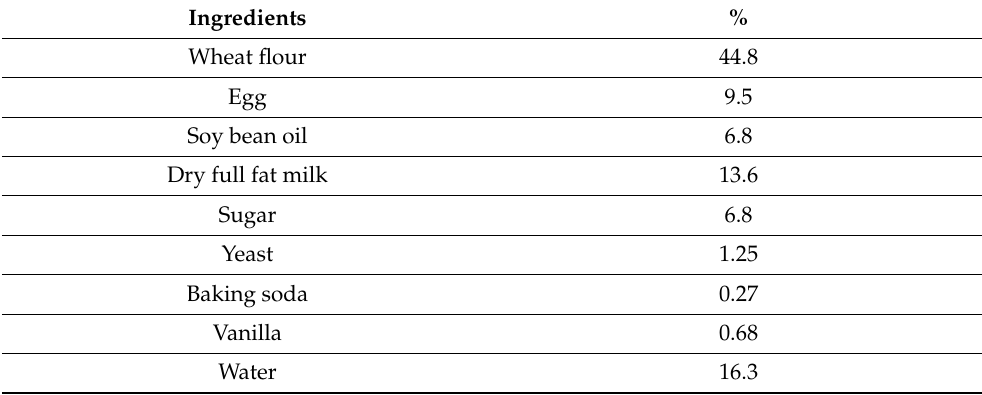
Table 1. Control cinnamon roll ingredients.